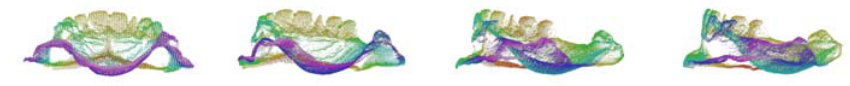
Fig. 4 Laser surface scan of the maxilla, displayed from various views.